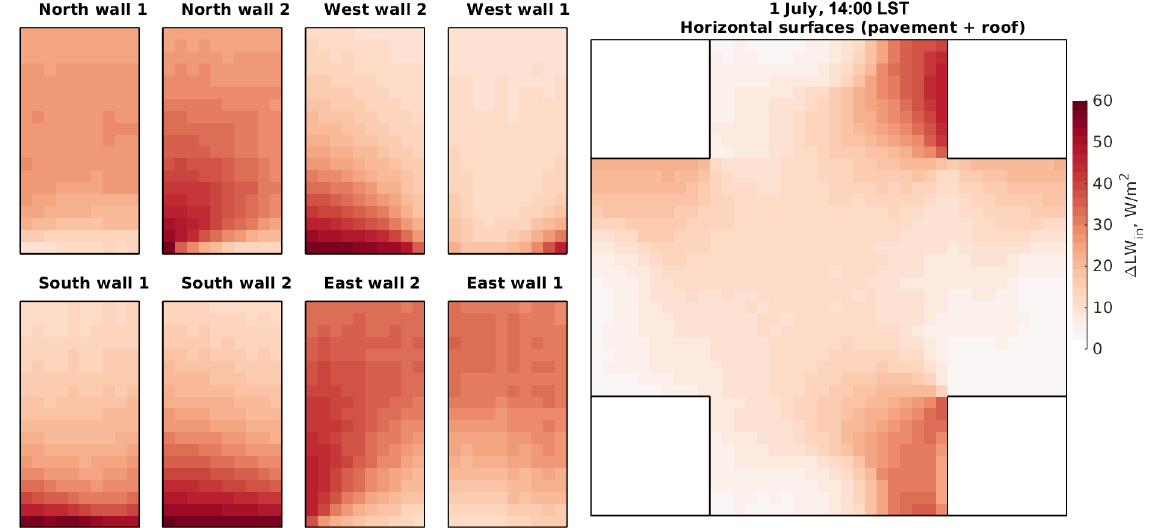
Figure 14. Changes in the received SW radiation flux within the focus domain of the simple urban configuration when considering one reflection (RTM_06) compared to RTM_05. Walls, roofs, and pavements are folded the same way as those in Fig. 6.